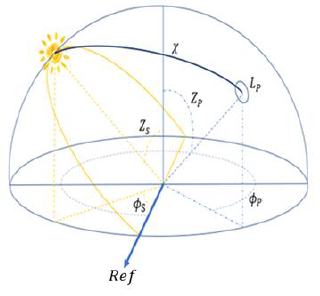
Figure 3. The angles of the sun and the sky element p.